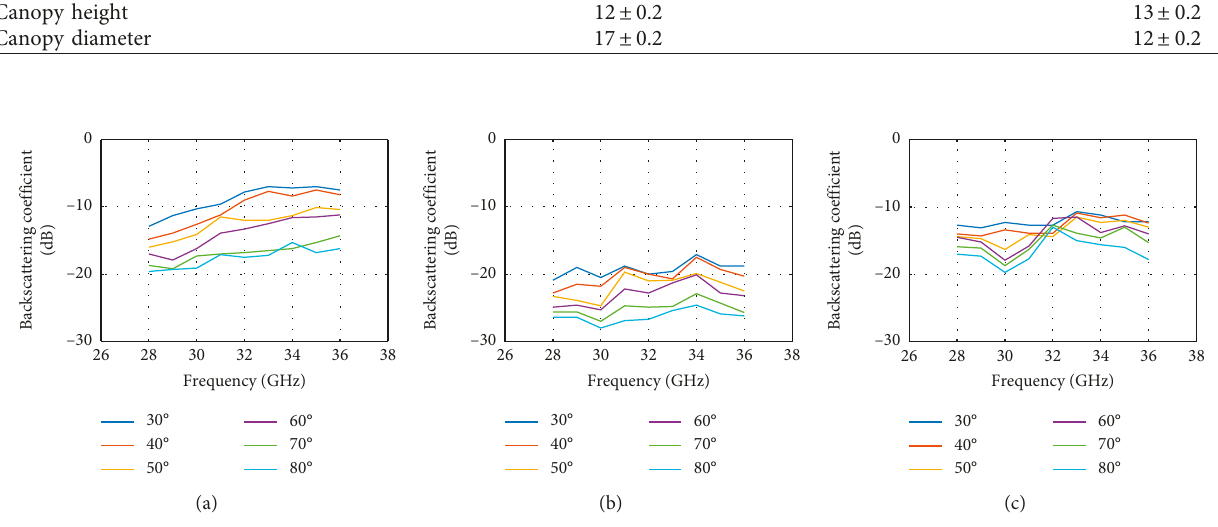
Figure 6: Frequency responses of the backscattering coefficient for the banyan tree in (a) HH, (b) HV, and (c) VV polarizations in a 30 to 80 degree range of incidence.